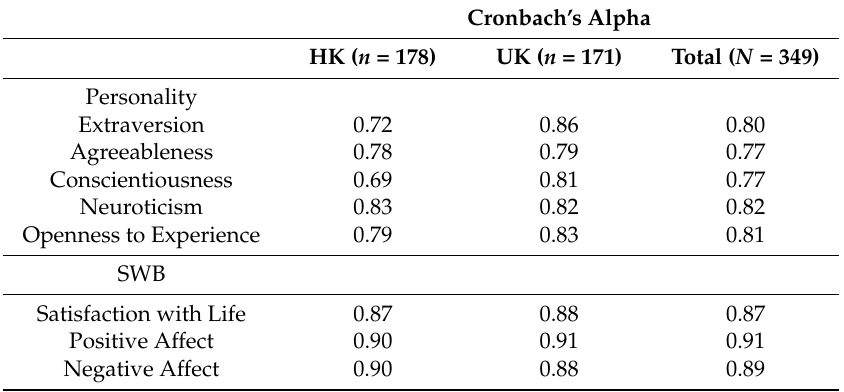
Table 2. Cronbach’s alpha scores of personality and subjective wellbeing (SWB)